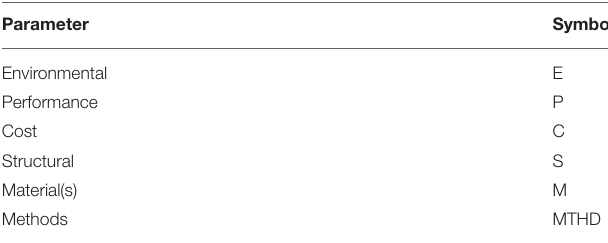
TABLE 1 | Symbols of the parameters used in Table 2